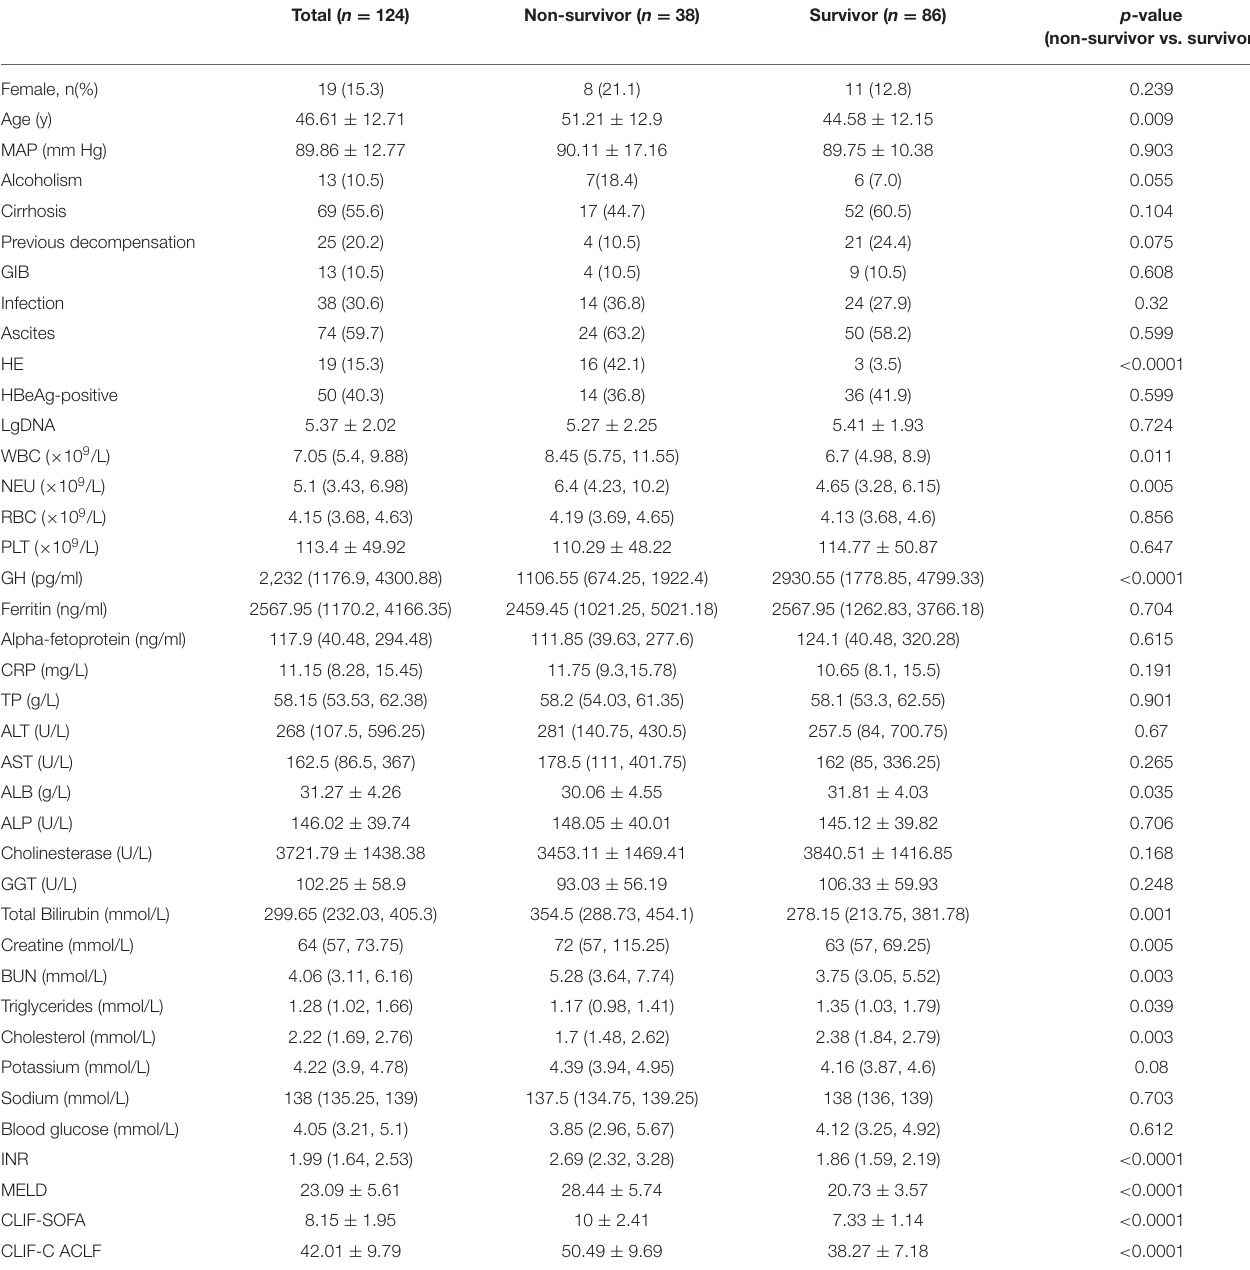
TABLE 1 | Characteristics of non-survivors and survivors in the HBV-ACLF cohort. Total ( n = 124) Non-survivor ( n = 38) Survivor ( n = 86) p -value